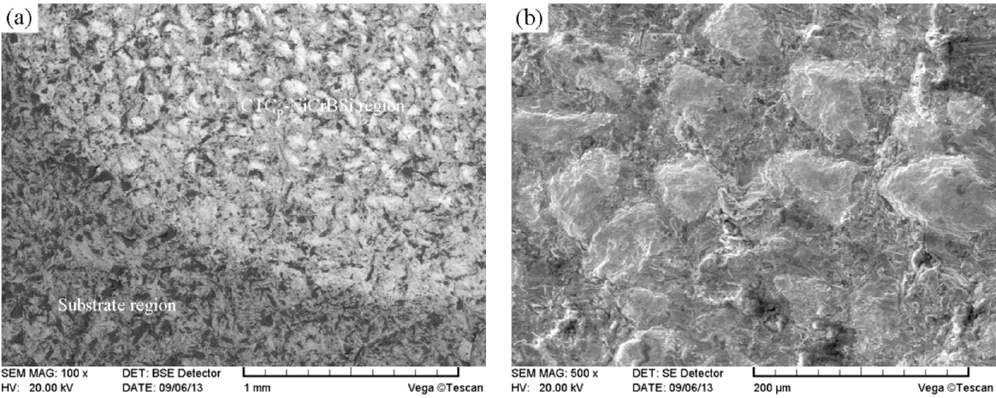
Figure 16. ( a ) Worn surface morphology of the modified CTC P -NiCrBSi/heat resistant steel composite layer, and ( b ) magnified worn surface morphology of the CTC P -NiCrBSi region at 600 °C.